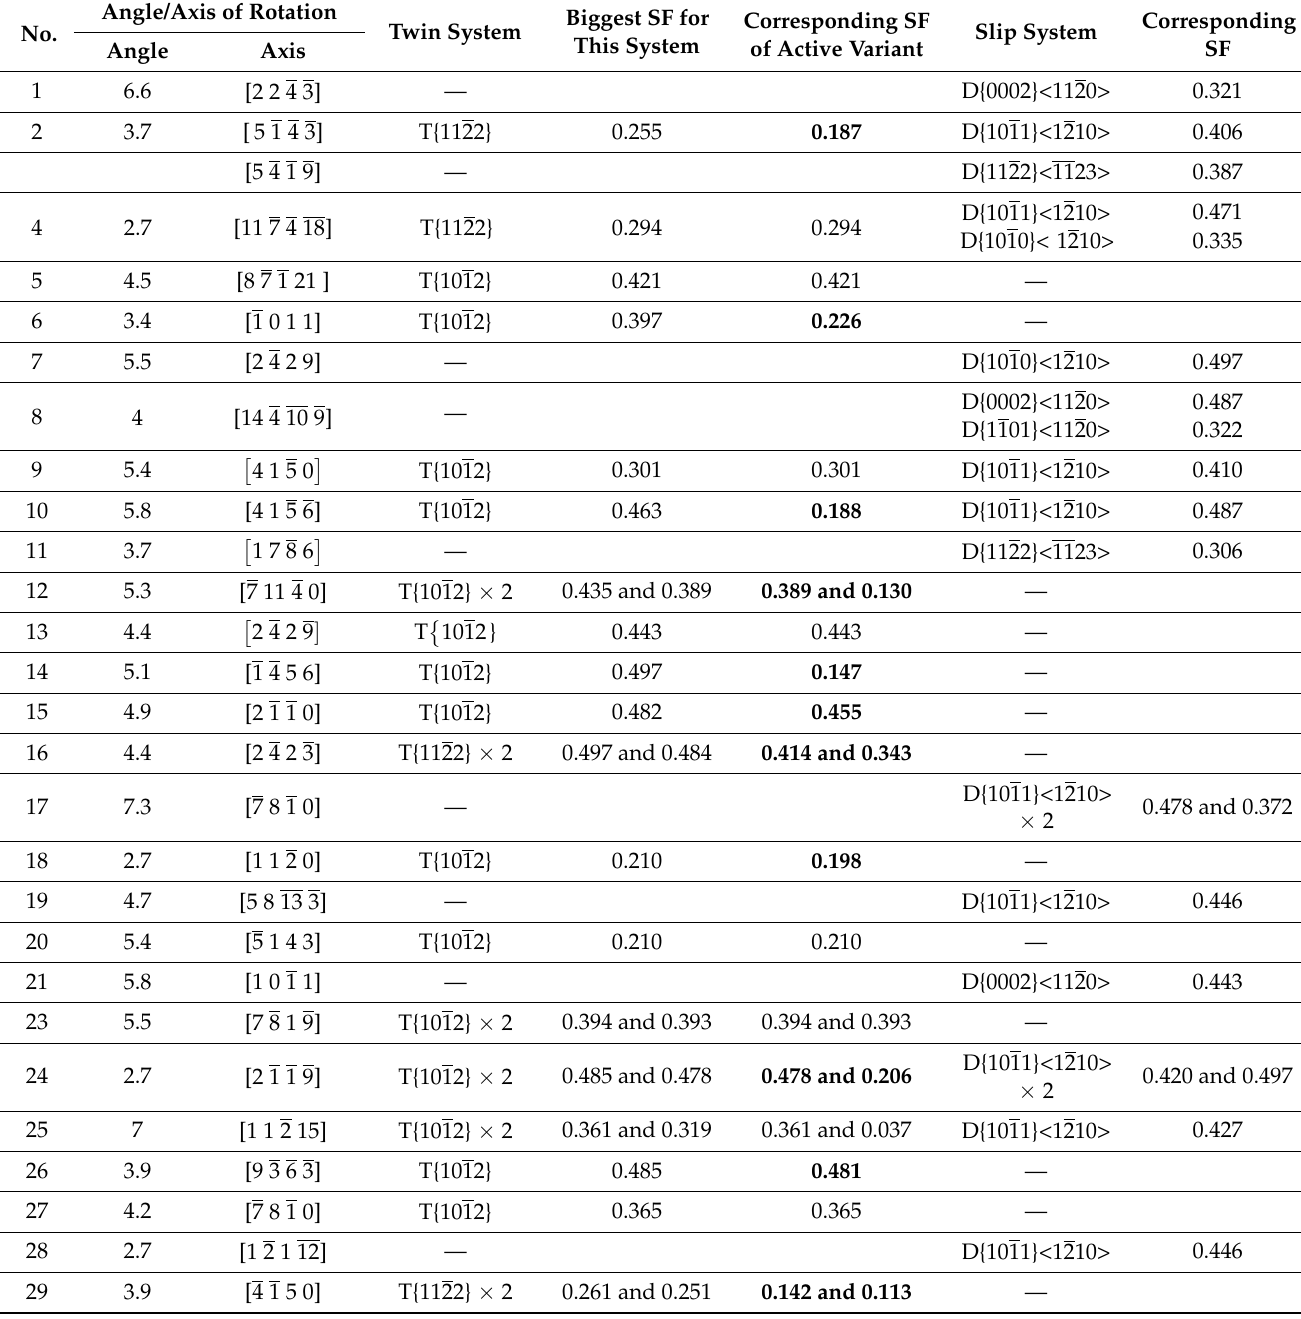
Table 1. Rotation, twinning, and slip systems of 29 observed grains, at the 0.05 strain level. The SFs of activated variants that do not have the largest SF of the six equivalent variants are marked in bold. ‘ × 2’ signs in twin and slip systems represent the two different equivalent variants